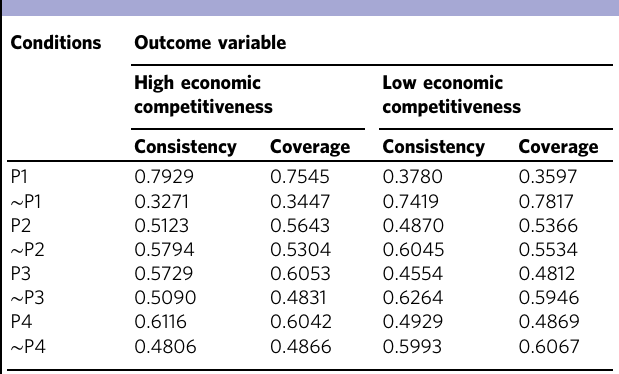
Table 1 Necessary condition analysis